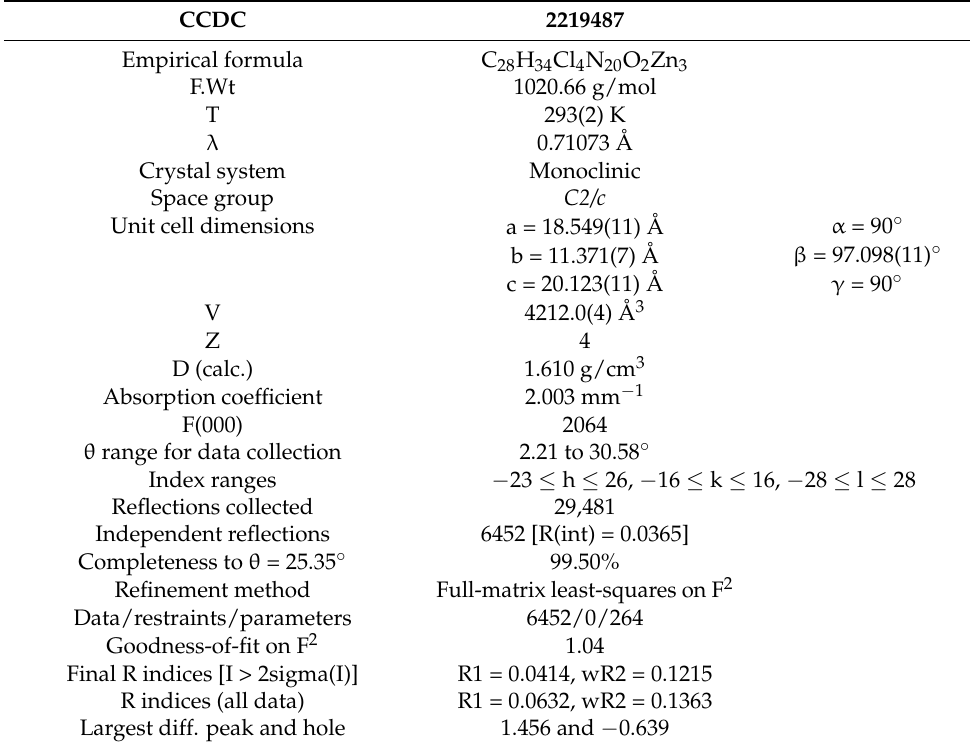
Table 1. Crystallographic data for the [Zn 3 (PMT) 2 (Cl 4 )(N 3 ) 2 ] complex.